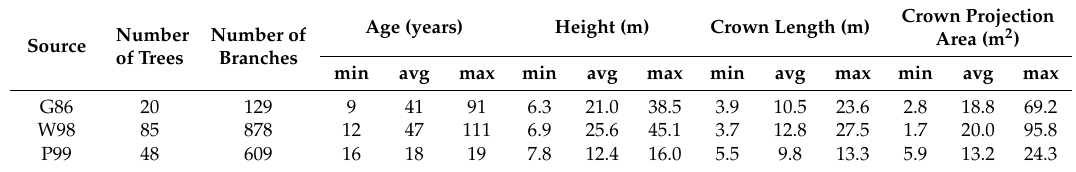
Table 1. Summary statistics from sample trees from three di ff erent